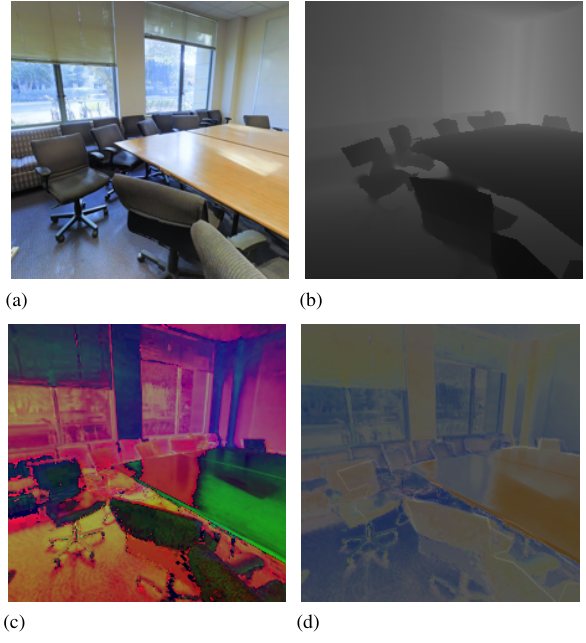
Figure 3. An exemplary image from the dataset: a) RGB; b) depth; c) HSD; d) R d G d B d